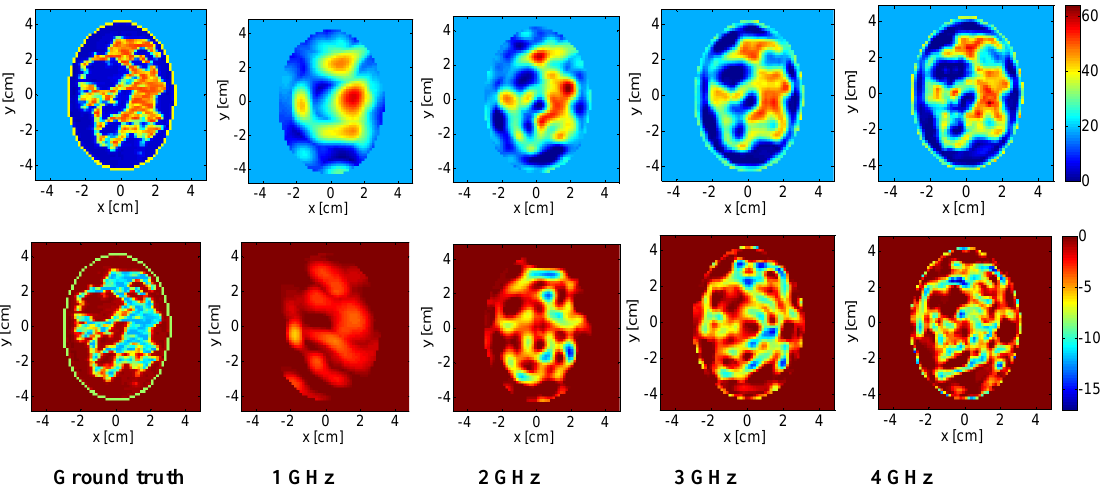
Figure 3. Very dense breast (ID 012304) . Real part ε′ ( top ) and imaginary part ε″ ( bottom ) of the reference permittivity and of the reconstructed profile at (from the left to the right) 1 GHz, 2 GHz, 3 GHz, and 4 GHz. Table 1. NMSE of heterogeneously dense breast (ID 062204).